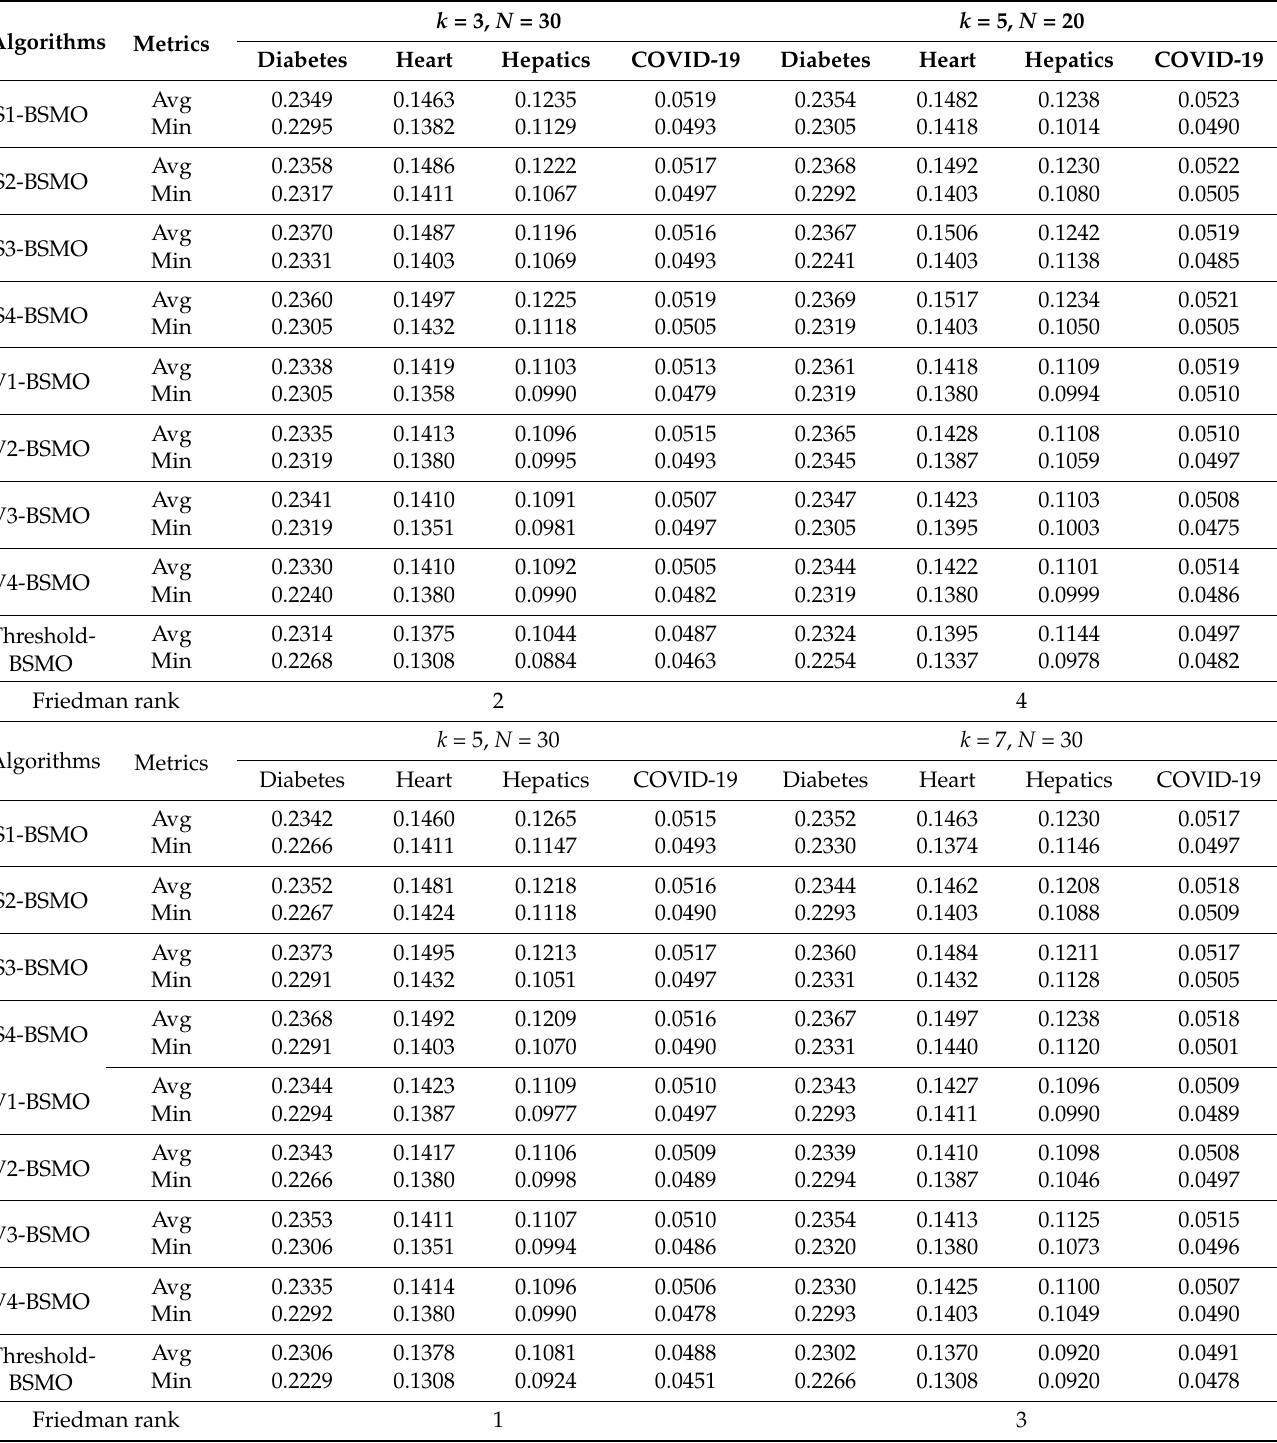
Table A1. Parameters setting of BSMO algorithm in terms of fitness